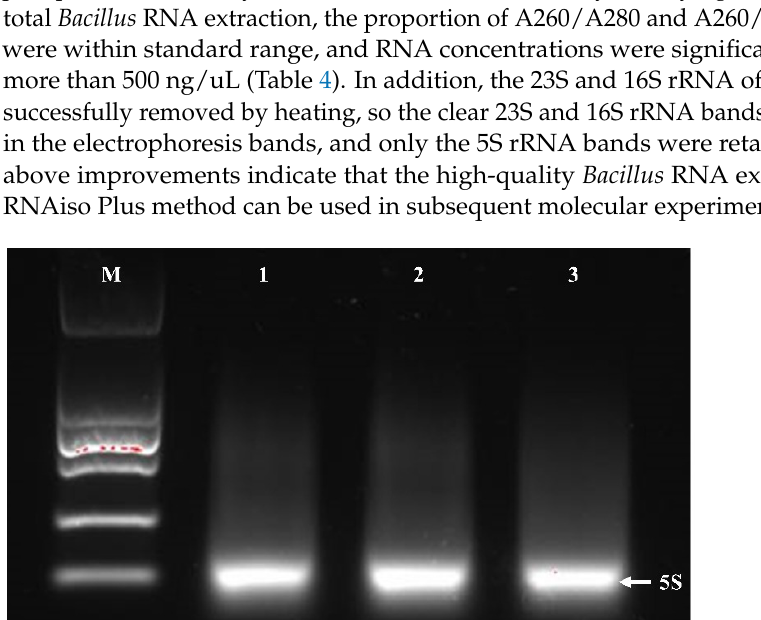
Table 4. Comparison of the quality and yield of total Bacillus RNA extracted by the different kits and the modified protocol. Method